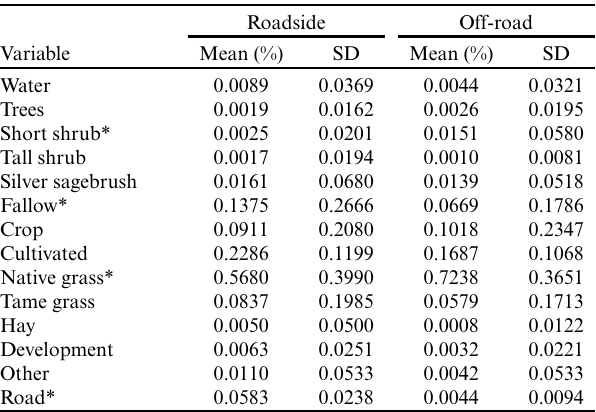
Table 1 . Mean and standard deviation (SD) of habitat variables measured on roadside ( n = 225) and off-road ( n = 225) point counts in the Prairie Ecozone of southern Alberta,